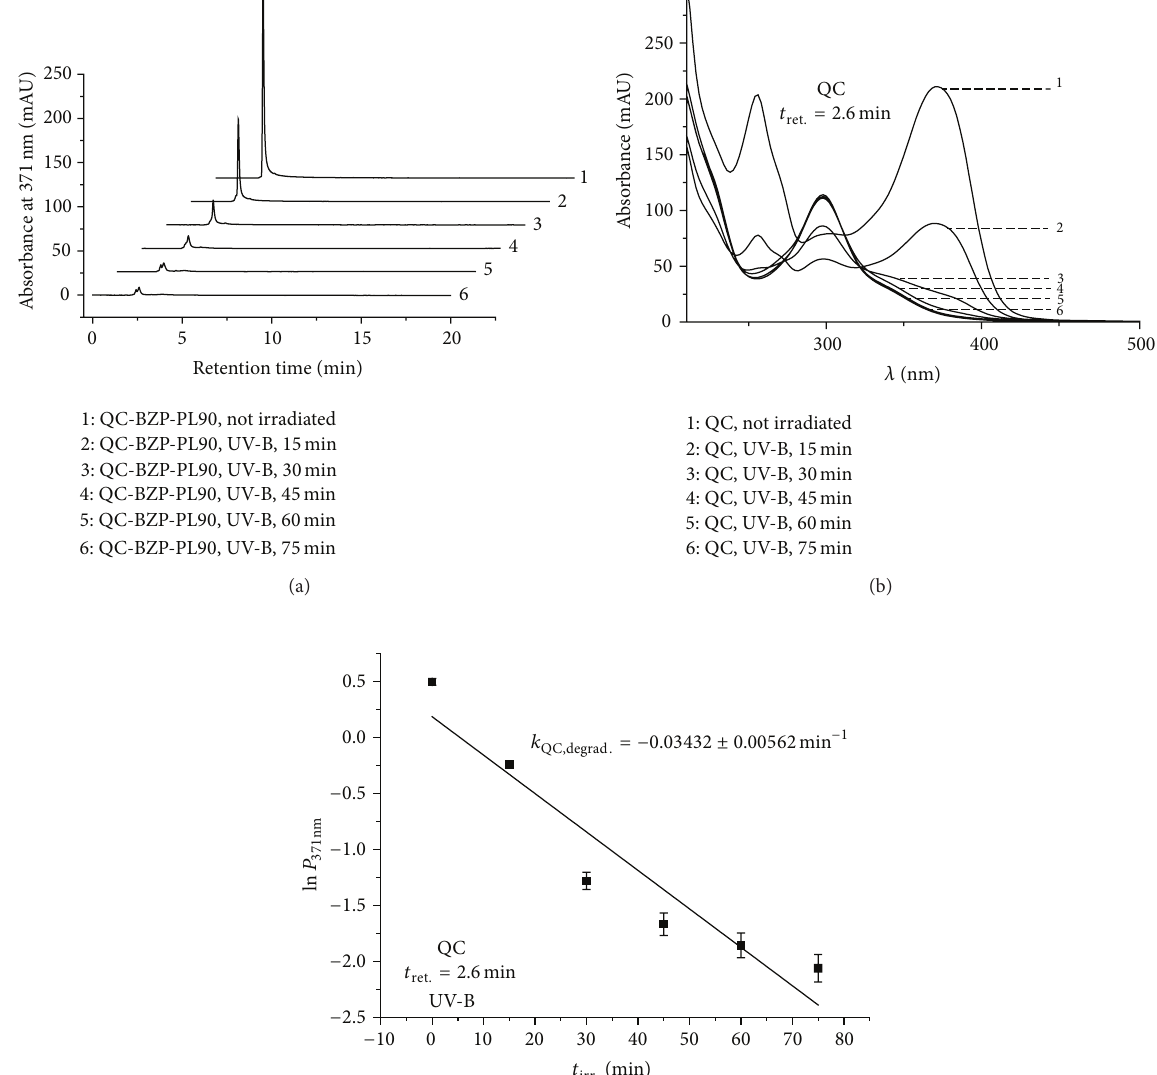
, of 2.6 min). (b) Changes in quercetin absorption ret . = 2.6 min), as a result of the increasing UV-B irradiation periods ret . = 2.6 min) integrated areas as ret . = 𝑓(𝑡 ) . The corresponding bleaching rate constant and the related error bars nm irr .